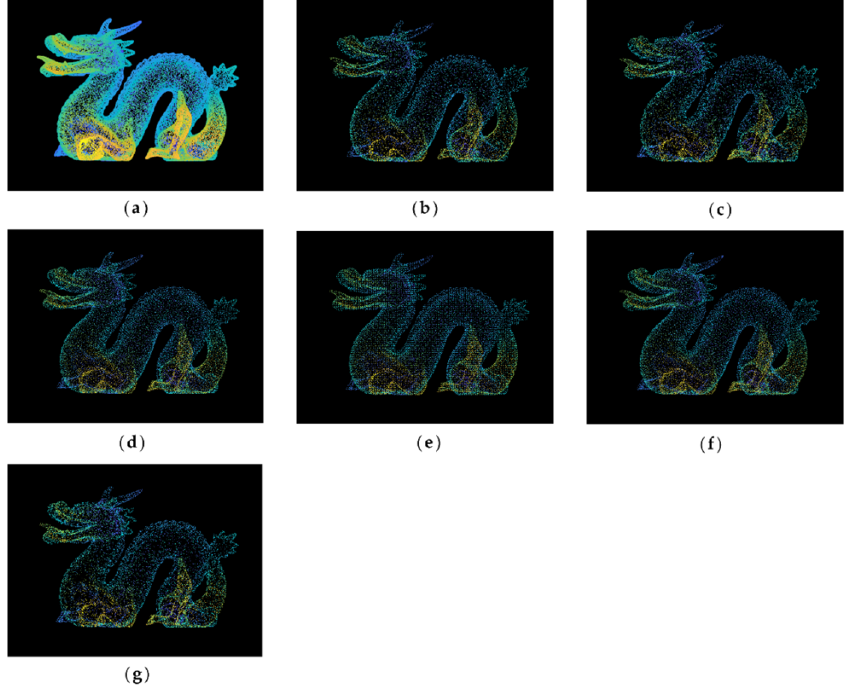
Figure 4. Original and simplified point clouds of the dragon dataset: ( a ) original point cloud; ( b ) MIWSA; ( c ) random algorithm; ( d ) normal algorithm; ( e ) voxel algorithm; ( f ) k-means algorithm; ( g ) curvature algorithm.